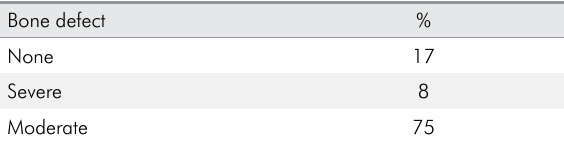
Table 1. Overview of patient population (need for bone augmentation).